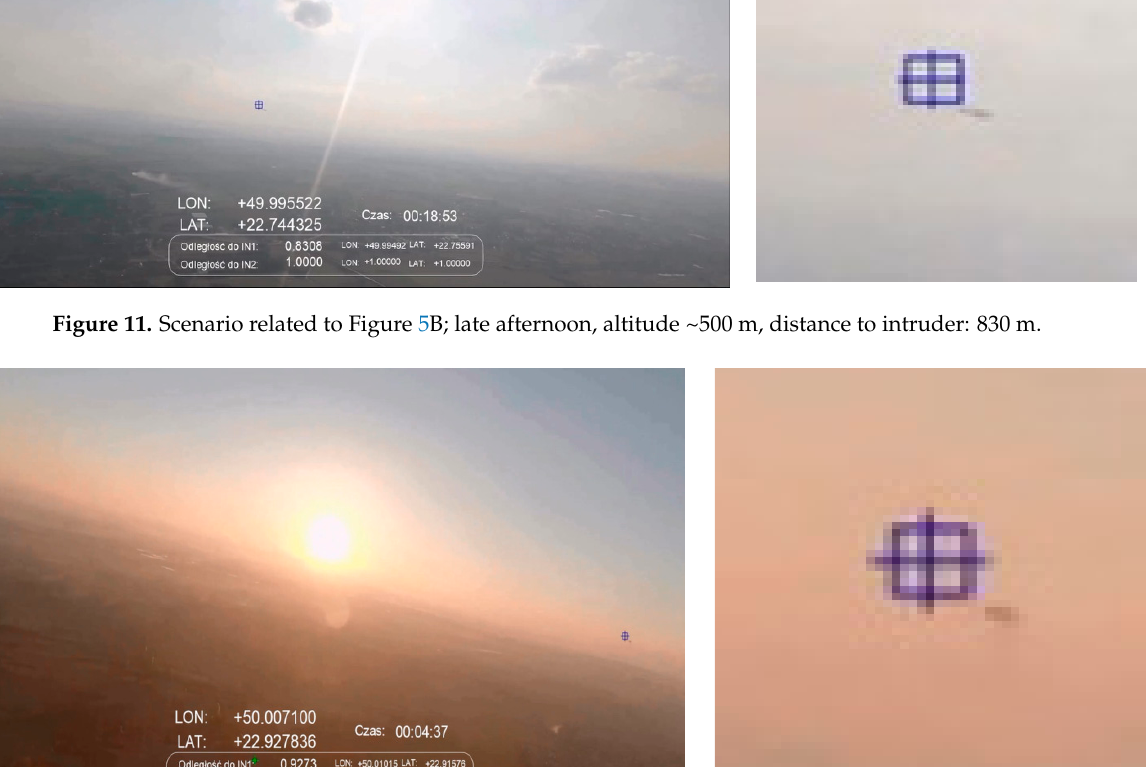
Sensors 2021 , 21 , x FOR PEER REVIEW 15 of 19 Figure 12. Scenario related to Figure 5B; sunset, altitude ~500 m, distance to intruder: 927 m.